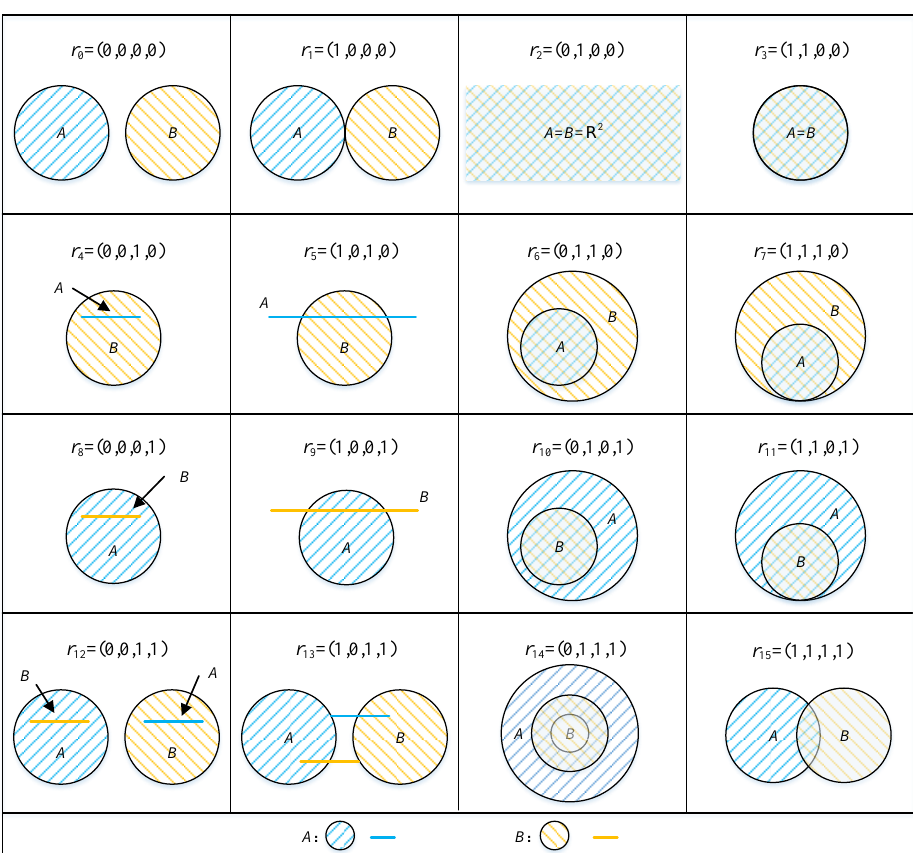
Figure 5. The topological spatial relations in the real number